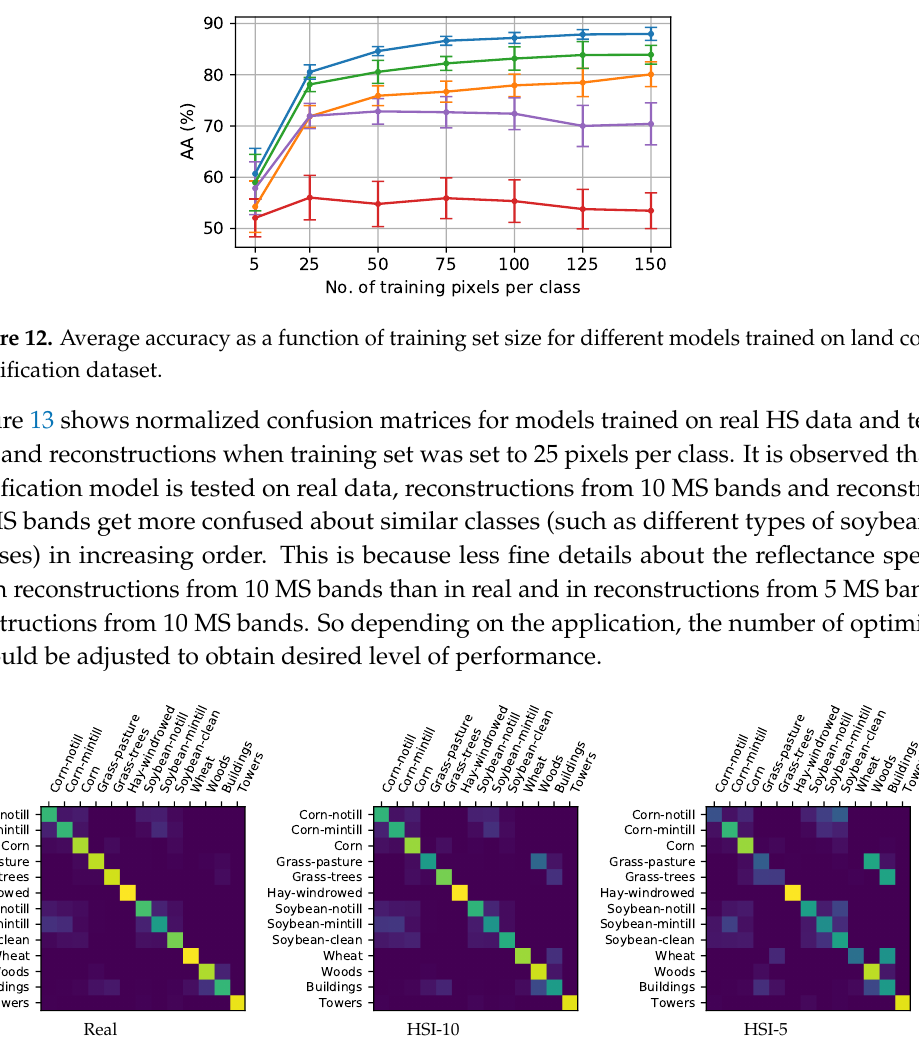
Figure 13. Normalized confusion matrices (25 training samples per class) averaged over 30 trials for classification model trained on real data and tested on real, HSI-10 (reconstruction from 10 MS bands), and HSI-5 (reconstruction from 5 MS